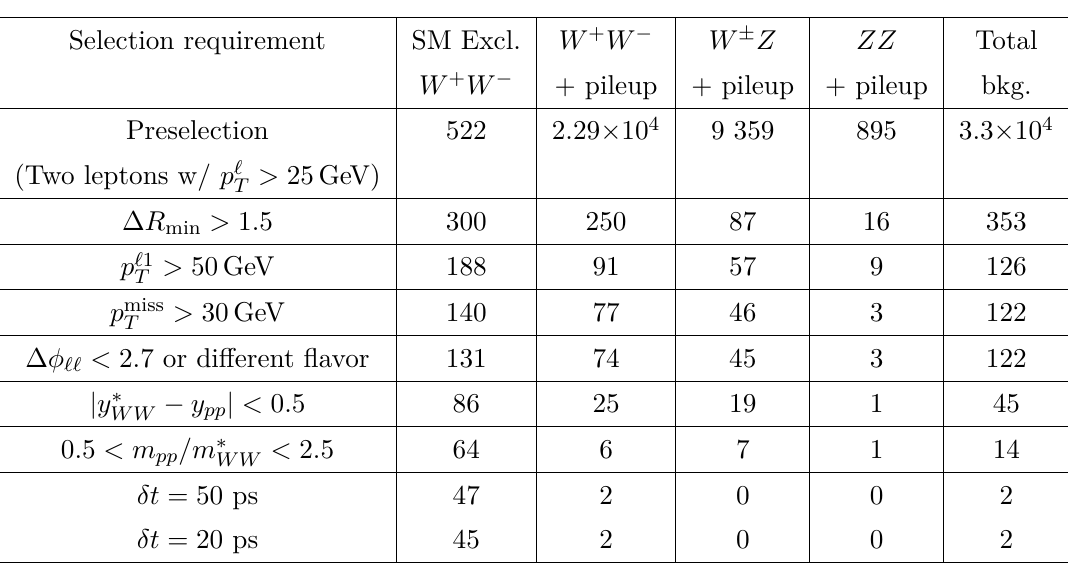
Figure 8 . Rapidity difference y pp − y ∗ (left) and mass ratio m pp /m ∗ (right) distributions WW WW for leptonic decays of SM exclusive W + W − events (black full line) and pileup background (red dashed line) normalized to unity, after preselection requirements, and lepton kinematic requirements summarized in table 3.